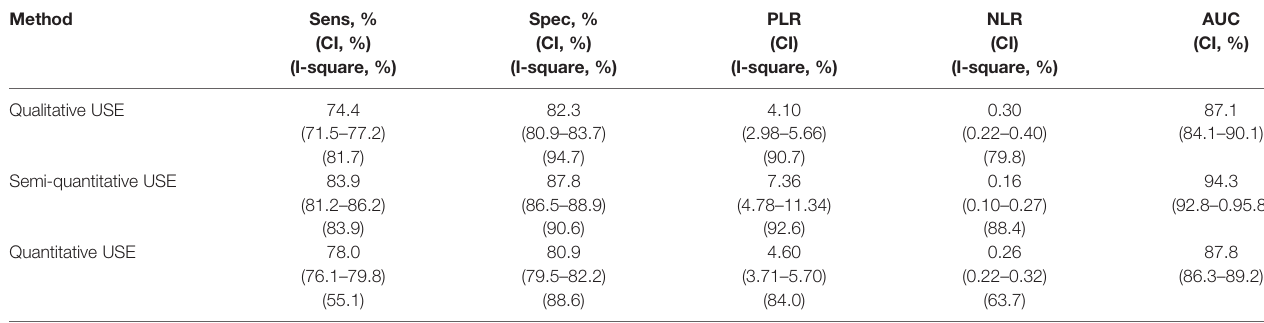
TABLE 5 | Pooled diagnostic performance of qualitative USE using only prospective papers. USE, Ultrasound Elastography.